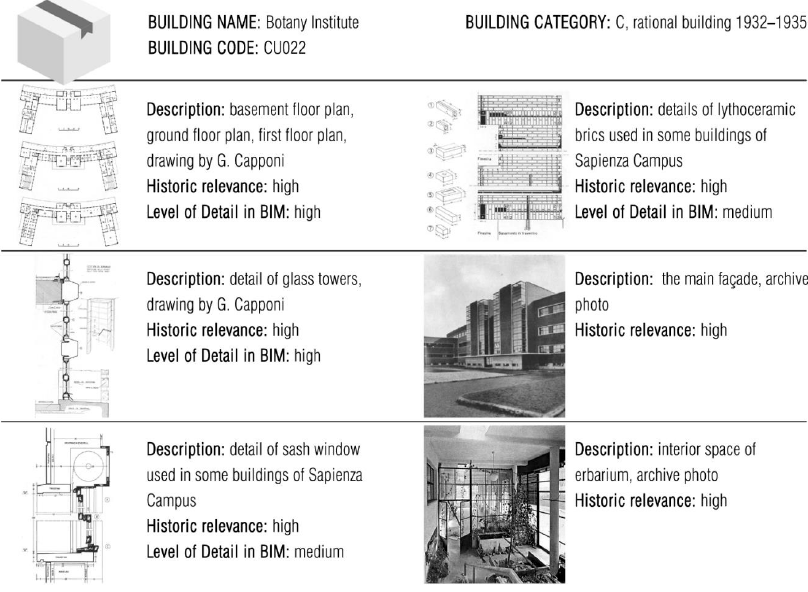
Figure 8. The Botany Institute, historical image of the internal space derived from bibliographic research.